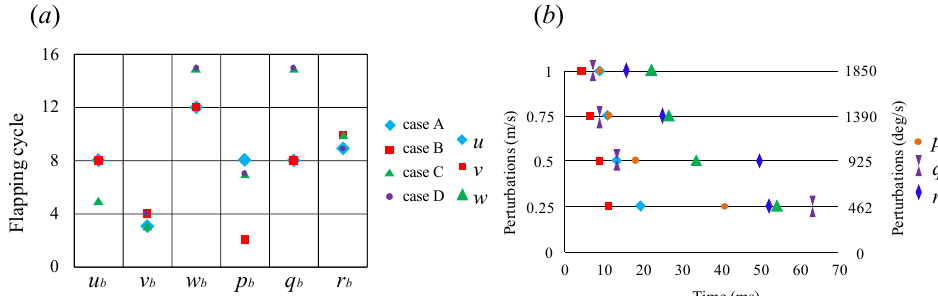
Figure 5. ( a ) Flapping cycles before a fruit fly loses its body attitude in four cases with different initial times: A, pronation; B, mid-downstroke; C, supination; D, mid-upstroke. ( b ) Time lapse from the outset of disturbances to the instance when a fruit fly begins to lose its body attitude under a wide range of